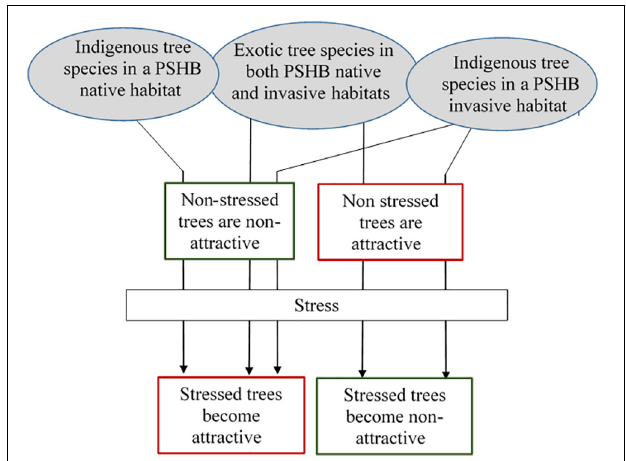
FIGURE 3 | A theoretical model suggesting the probability of a tree species becoming attractive or non-attractive to PSHB attack.